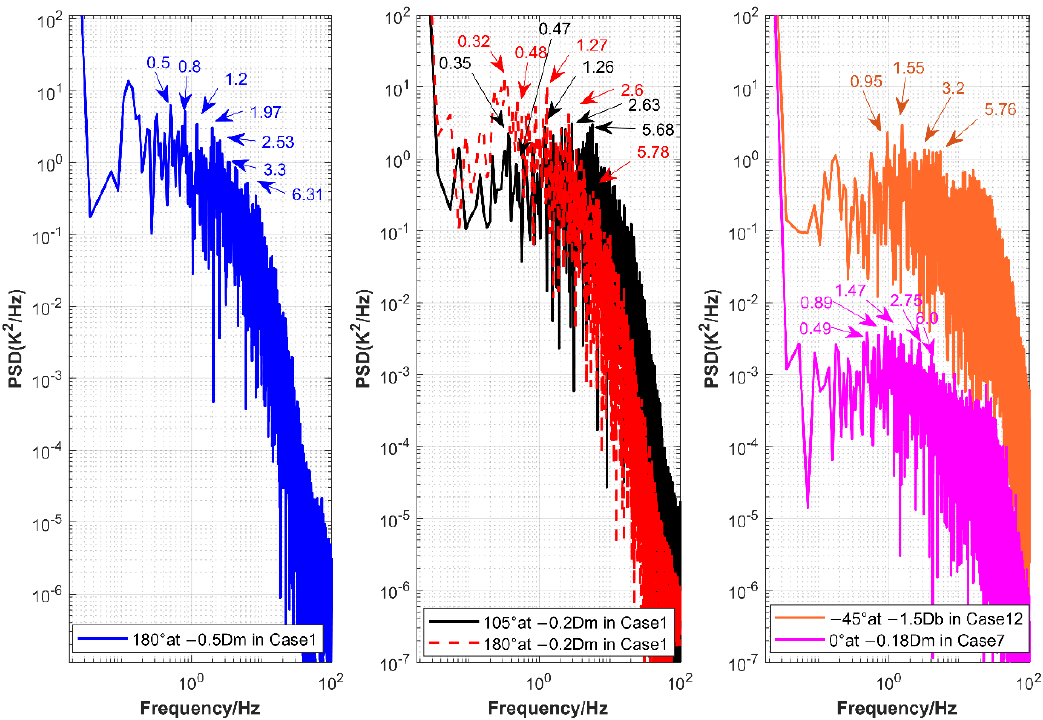
Figure 15. Power spectrum density of the temperature in Case1, Case7, and Case12.